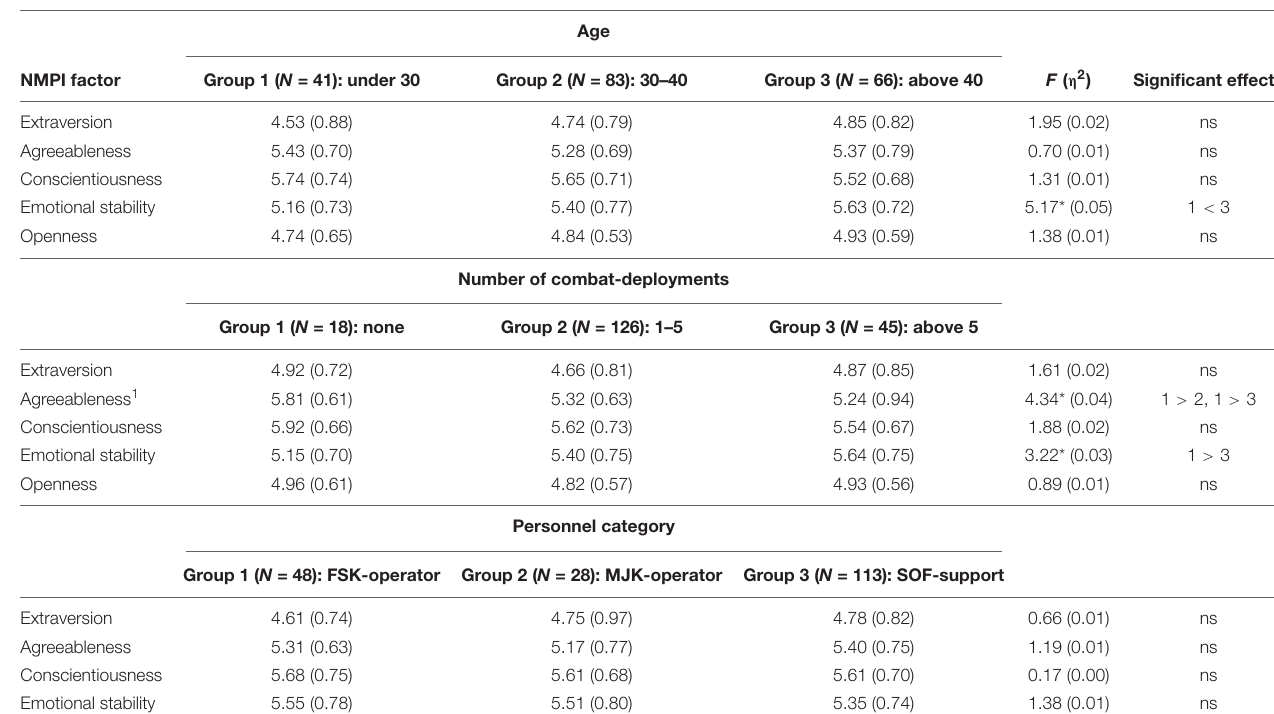
TABLE 2 | NMPI factor means, standard deviations and one-way between-groups analyses of variance using age, number of combat-deployments and personnel category as